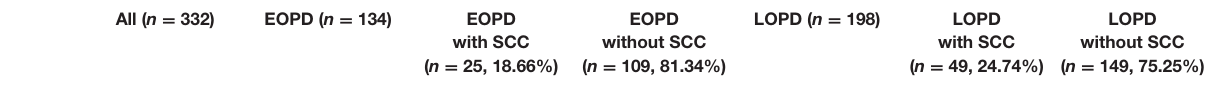
TABLE 1 | Demographic and clinical features of the patients with EOPD and